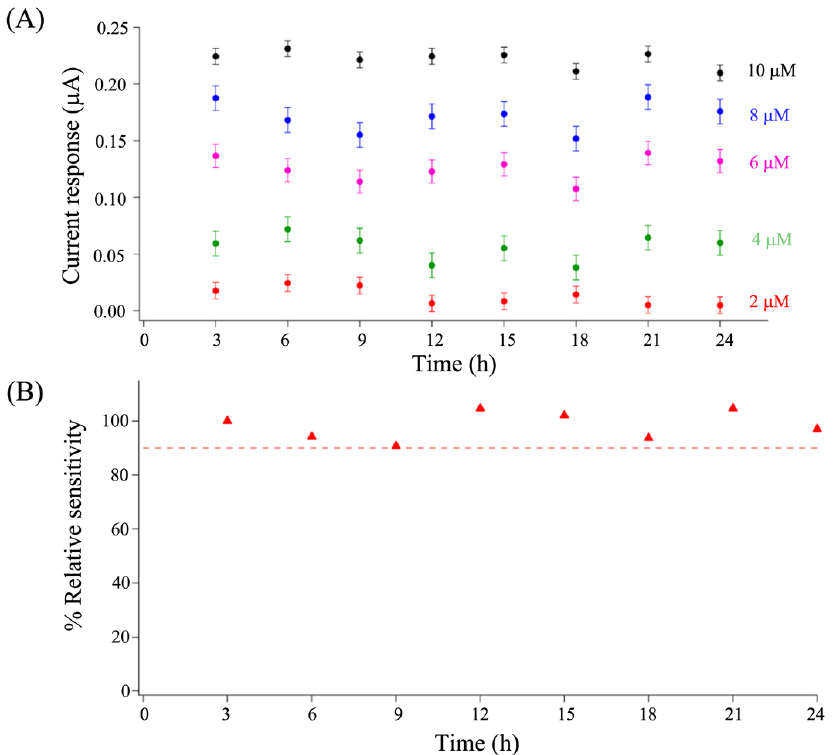
Figure 7. Stability of the serpentine microfluidic OMC-PEDOT-PSS/SPCE platform. ( A ) Current responses in each DA concentration. The plot was obtained when continuous monitoring of DA for 24 h (recorded every 3 h) was carried out in a range of 2 to 10 µ mol L − 1 DA concentration at a constant 2.0 µ L min − 1 total flow rate. ( B ) Plotting relative sensitivity of the developed sensor for a period of 24 h.